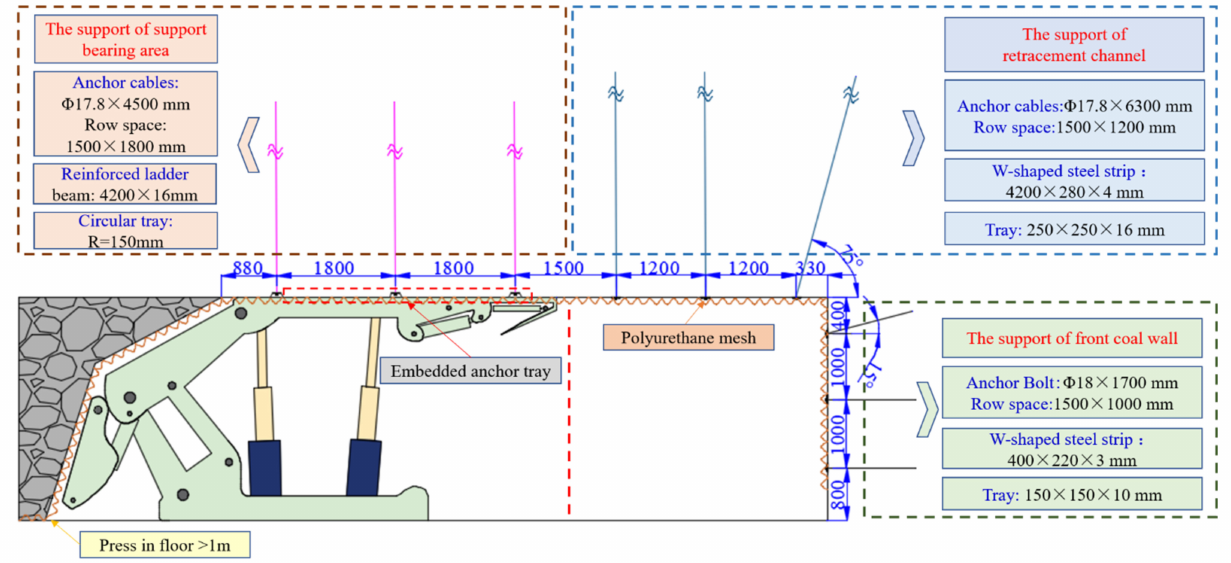
Figure 24. Asymmetric support parameters of stopping space.